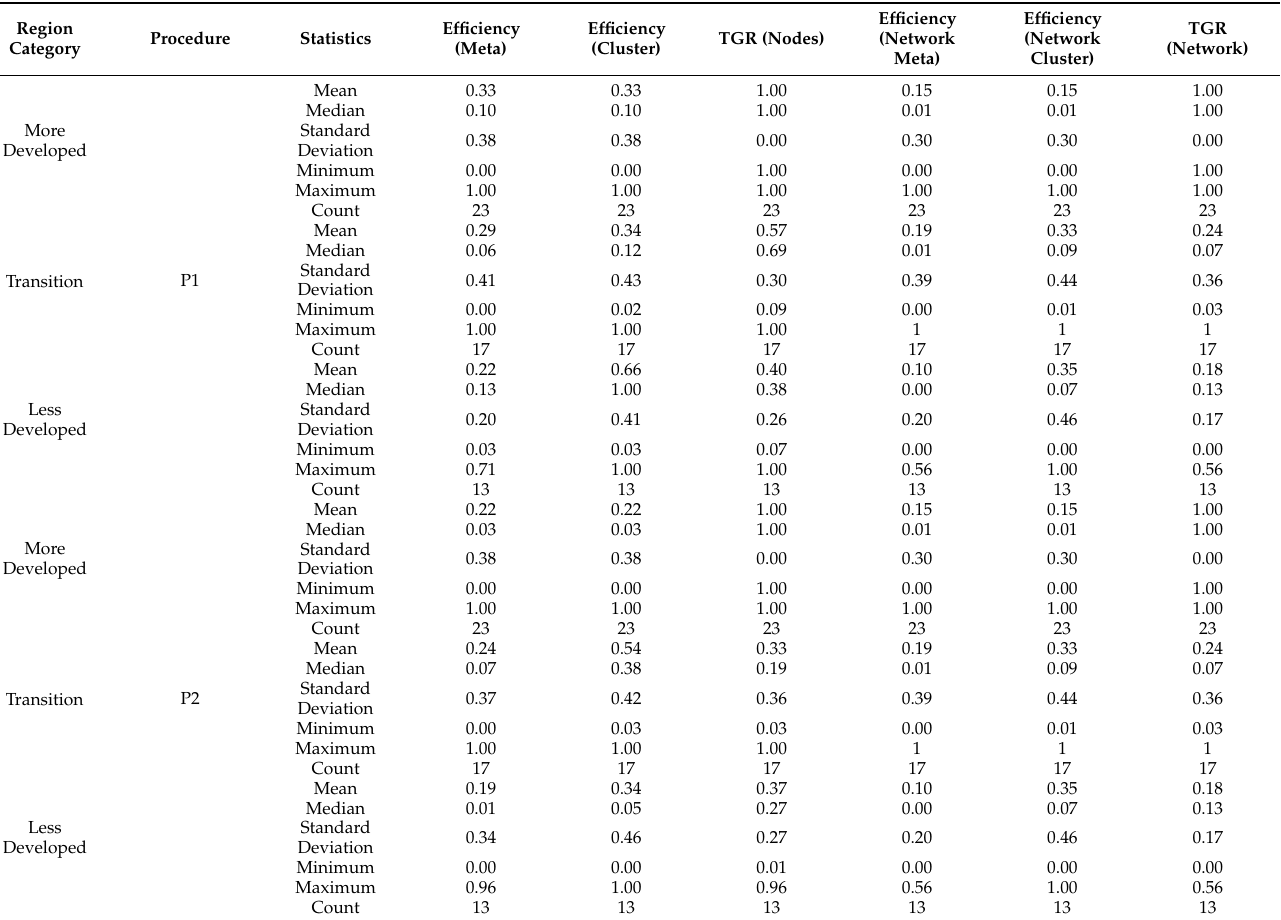
Table 7. Descriptive Statistics of the results obtained for the